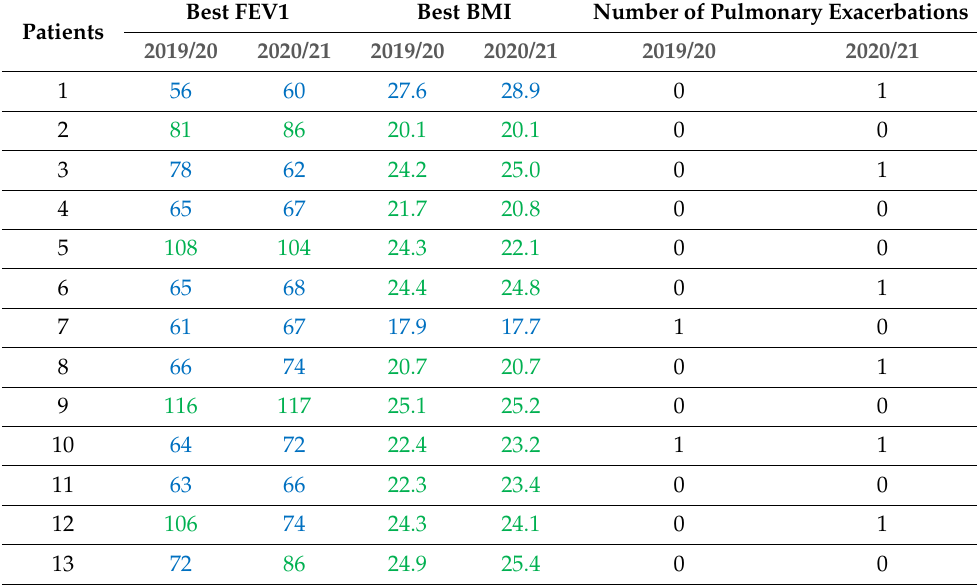
Legend: borderline values; normal